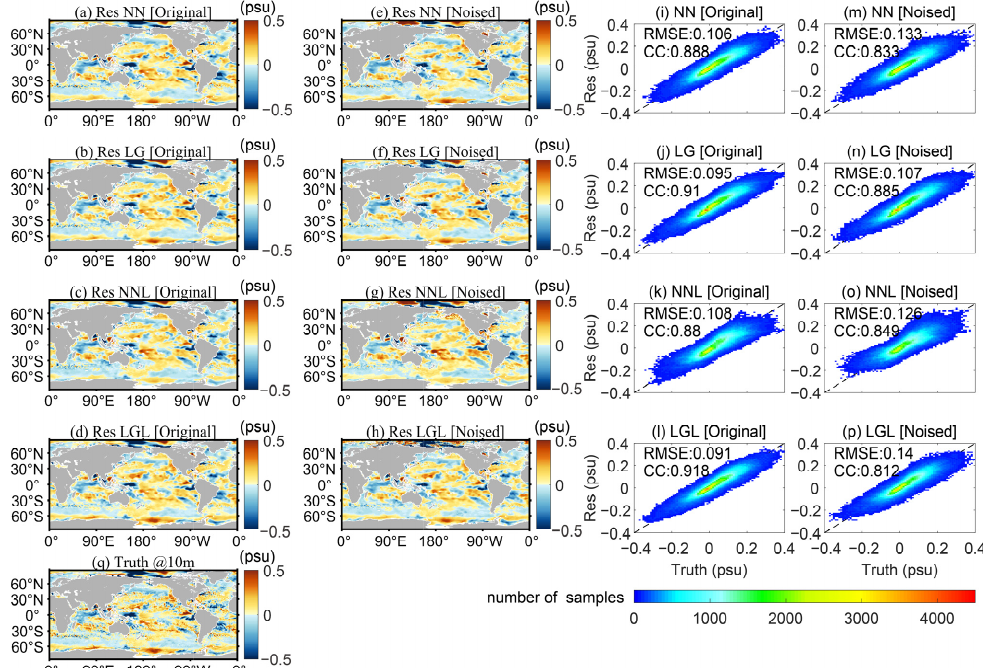
Figure 3. Spatial distribution of reconstructed data and density scatter plots of reconstructed vs. truth values for the four experiments at 10 m depth in January 2016. ( a – d ) and ( i – l ) Reconstruction based on the original synthetic dataset. ( e – h ) and ( m – p ) Reconstruction based on the noised synthetic dataset. ( q ) Truth value of CNRM-CM6-1-HR. The color-coded dots represent the number of samples.